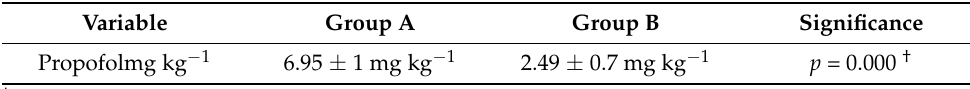
Table 2. Requirement of